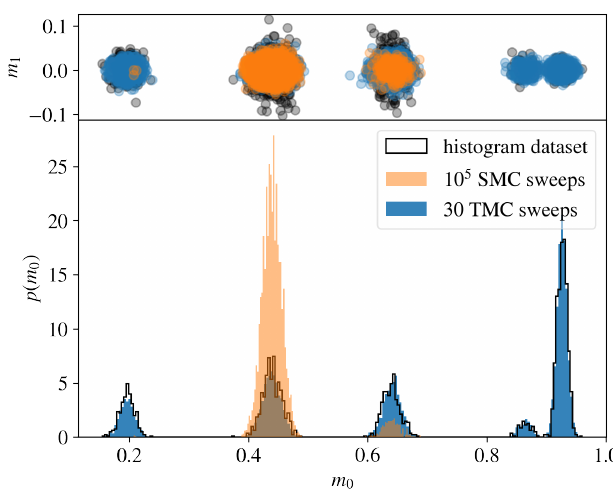
Figure 1: We illustrate the difficulties of sampling a multimodal distribution with standard Glauber MC moves of a dataset of 5 aligned point clusters in high dimen- sions. On the top, we show the projection of the dataset / generated samples along the first ( m ) and the second ( m ) dataset’s principal components. Each dot is one 0 1 sample. In the bottom, we show the histogram of all these m . The original dataset is 0 displayed in black, and the generated datasets are shown in blue or orange, depend- ing on the algorithm used to sample the configuration space of the exactly trained RBM from Ref. [ 24 ] , from random initializations. Orange samples are obtained after 10 5 standard Glauber MC (SMC) steps and blue samples, after 30 TMC